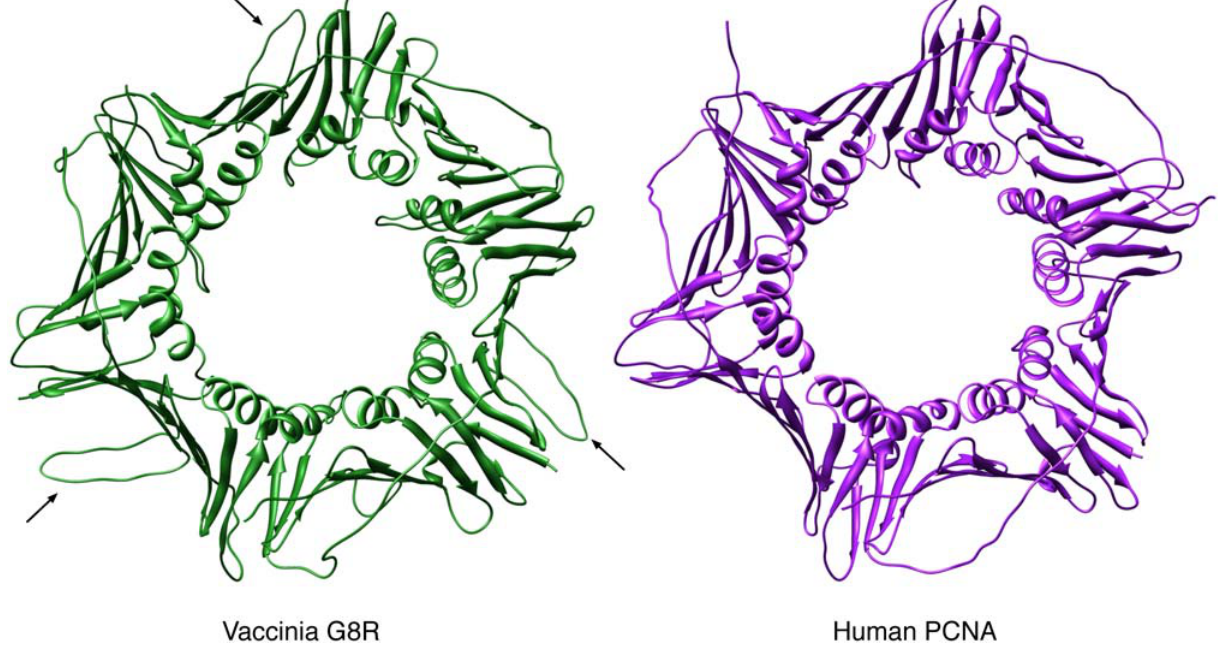
Figure 4. Complete trimer of the VACV G8R and human PCNA protein donut structures. Arrows mark the loop region between beta- strands 8 and 9 of the VACV G8R protein.